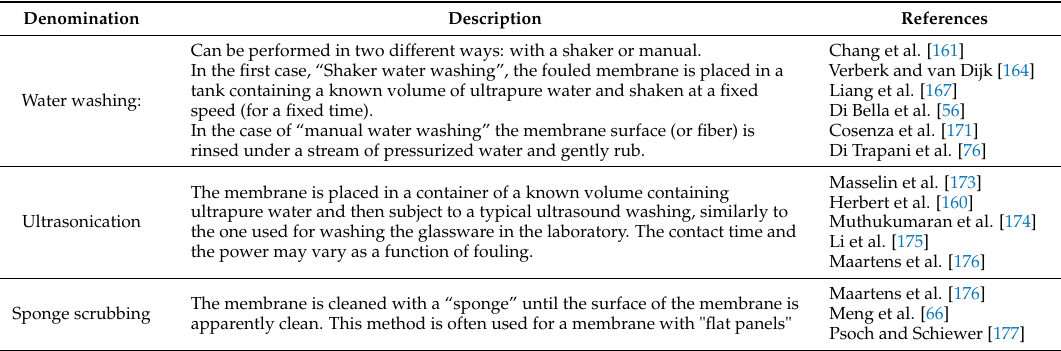
Table 2. Classification of different Physical cleaning